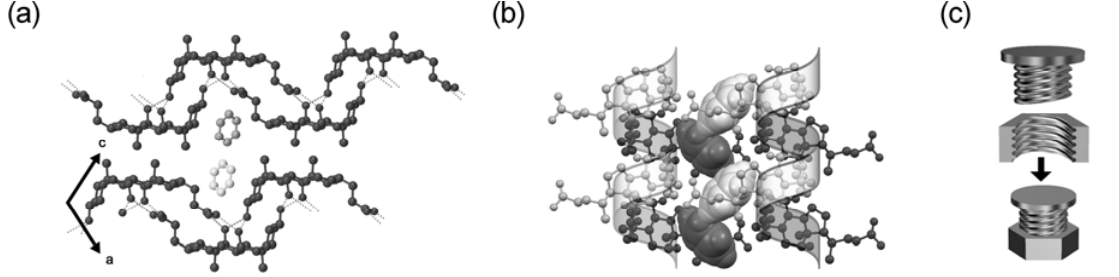
Figure 17. Complementary chirality of the 2 helical assemblies of host and guest 1 components. The inclusion crystal of Ia with benzene (a), bundles of right-handed helical assemblies of Ia and benzene (b), and a combination of a right-handed bolt and nut